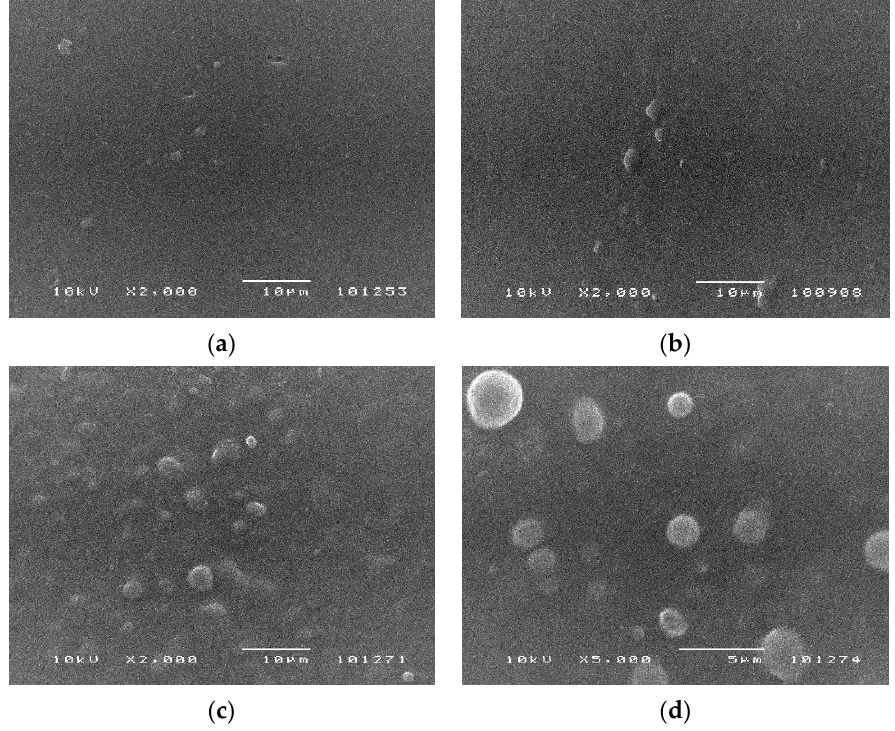
Figure 1. SEM pictures (×2000) of a typical sample of incisor replicas from the group of patients treated with hydrogen peroxide (HP Group). Compared with the physiological permeability highlighted at ( a ) baseline, the replicas relating to the two experimental times (T1 and T2) show variation in the ( b ) permeability of enamel with a relative increase of number and diameter of droplets at T1 and ( c ) a substantial increase in the permeability of the enamel, with large and numerous droplets covering the entire enamel surface at T2. In ( d ), a higher magnification (×5000) of the large fluid droplets is reported.